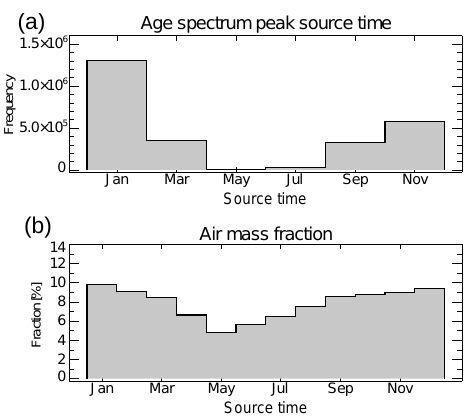
Figure 14. (a) Distribution of time of last contact with the boundary surface (source time) for age spectrum peak air. (b) Seasonality of time of last contact with the boundary surface for all stratospheric air masses. The distributions have been calculated from all CLaMS age spectra in the 380–1000K potential temperature layer during the 1989–2013